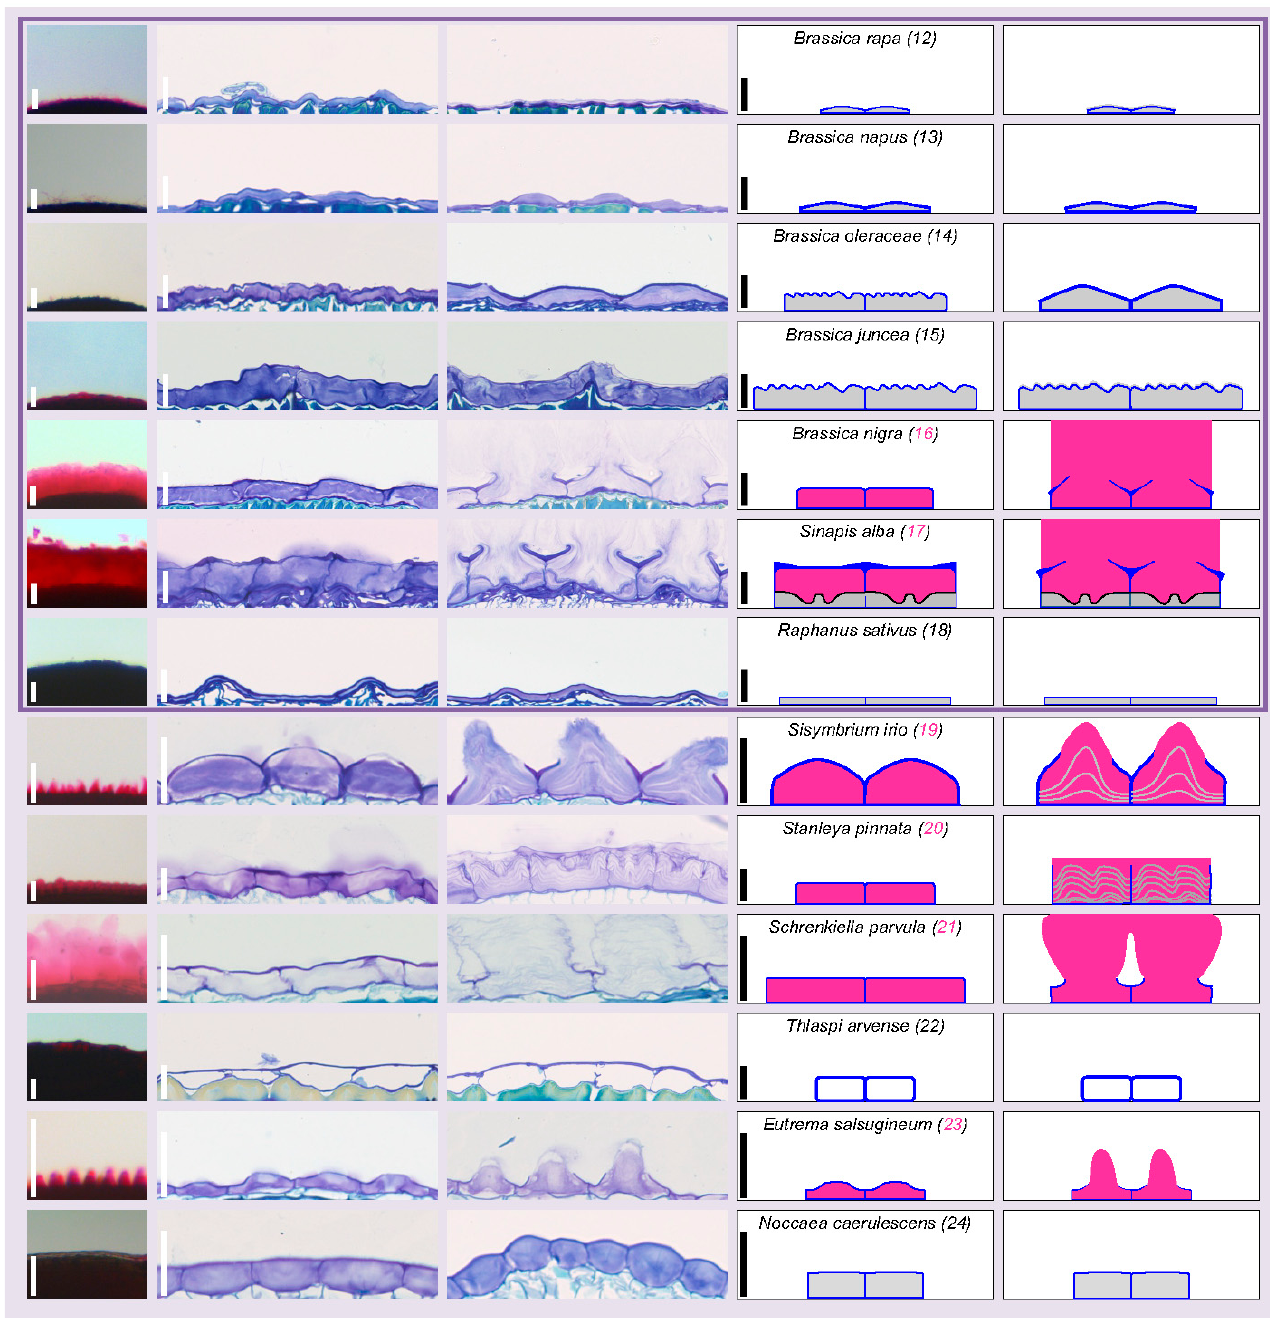
Figure 4. Brassiceae and other lineage 2 species seed epidermis/MSC morphology is highly diverse and contrasted as compared to lineage 1 species. Column 1: magnified view of imbibed seeds stained with ruthenium red (full images are shown in Figure 2) reminds the ability to release mucilage or not. Scale bar: 100 µ m. Columns 2 and 3: Toluidine blue histochemical staining of dry seeds and imbibed seeds, respectively, focusing on the outermost cell layer morphology and of mucilage release mode for myxospermous species. Note that the inner part of the seed is located below the imaged cells. Scale bar: 25 µ m. Columns 4 and 5: simplified drawings of two epidermal cells at the same scaling shown in Toluidine blue images. For each line the species name, the species number (pink for myxospermous and black for non-myxospermous species), as well as the scale of cross sections is reminded in column 4. A color code is applied for mucilage (pink), primary wall (blue), columella or columella-like structure (green), intracellular unidentified structures or sublayering